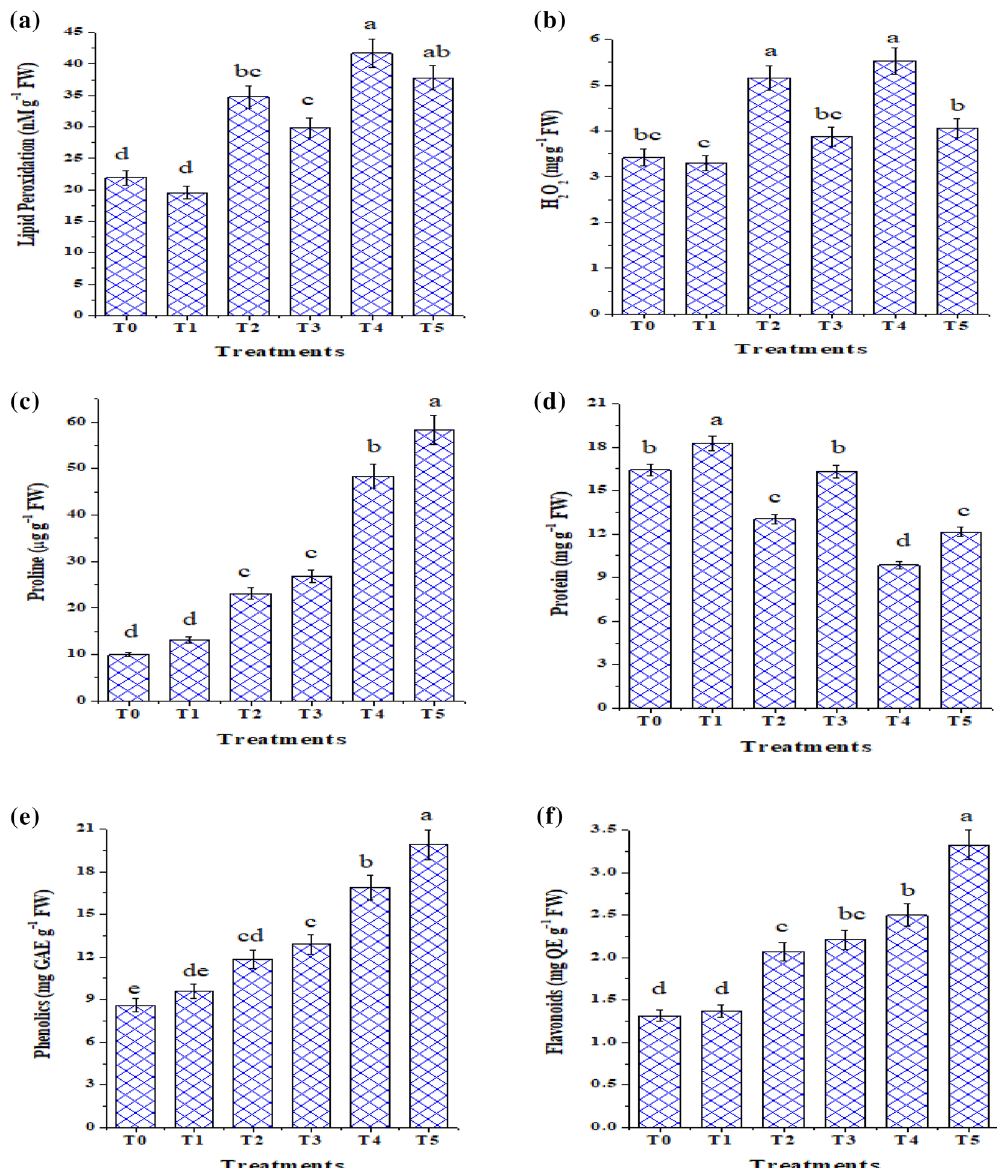
Fig. 6 Effect of T. viride application on lipid peroxidation (nM/g FW), hydrogen peroxide (H 2 O 2 ) content (mg/g FW), proline (μg/g FW), protein (mg/g FW), total phenolic (mg GAE/g FW) and flavonoid (mg QE/ g FW) contents of tomato seedlings in response to salinity stress. T 0 , T 2 and T 4 represent tomato seedlings grown on MS medium under 0, 50 and 100 mM NaCl stress, while T 1 , T 3 and T 5 represent tomato seedlings grown on MS medium with T. viride under 0, 50 and 100 mM NaCl stress . GAE: Gallic acid equivalent, QE: Quercetin equivalent *Data are the mean of five replicates standard error (n 5). Different letters above bars indicate a significant difference between treatments using ANOVA followed by ± = Duncan’s multiple range test ( p <